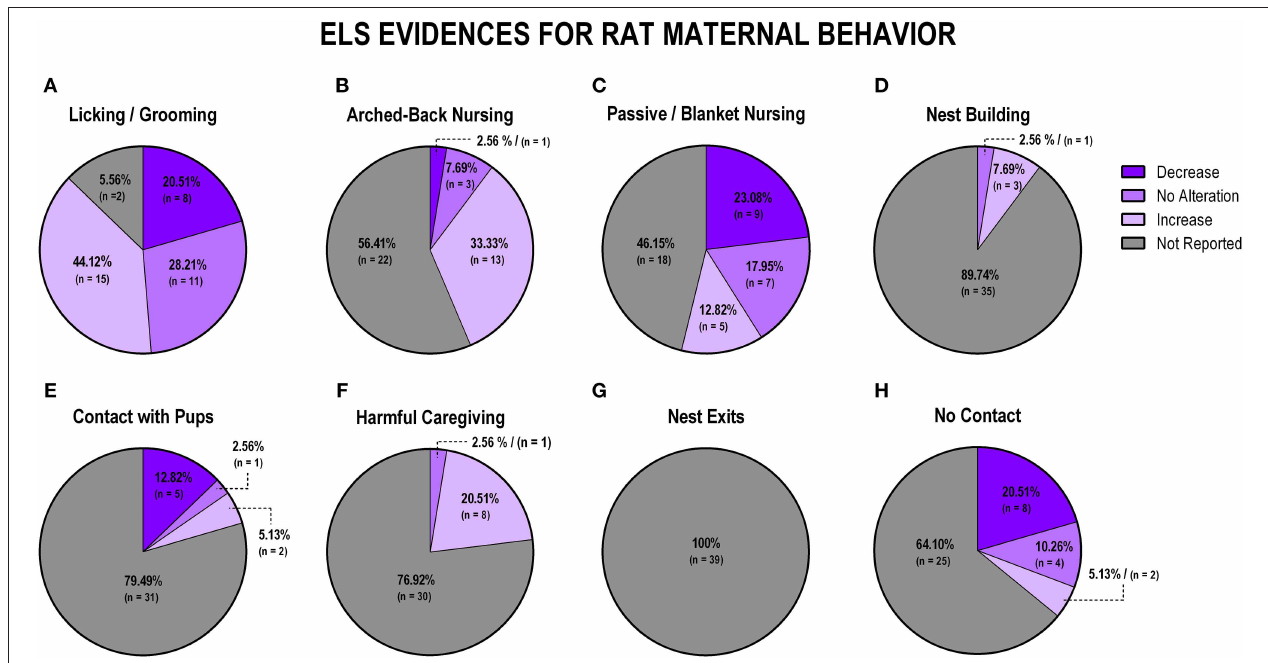
FIGURE 3 | Percentage of behavior findings from all rat studies. Licking and grooming behavior (A) . Arched-back nursing behavior (B) . Passive and blanket nursing behavior (C) . Nest building behavior (D) . Contact with pups behavior (E) . Harmful caregiving behavior (F) . Nest exits behavior (G) . No contact behavior (H) .